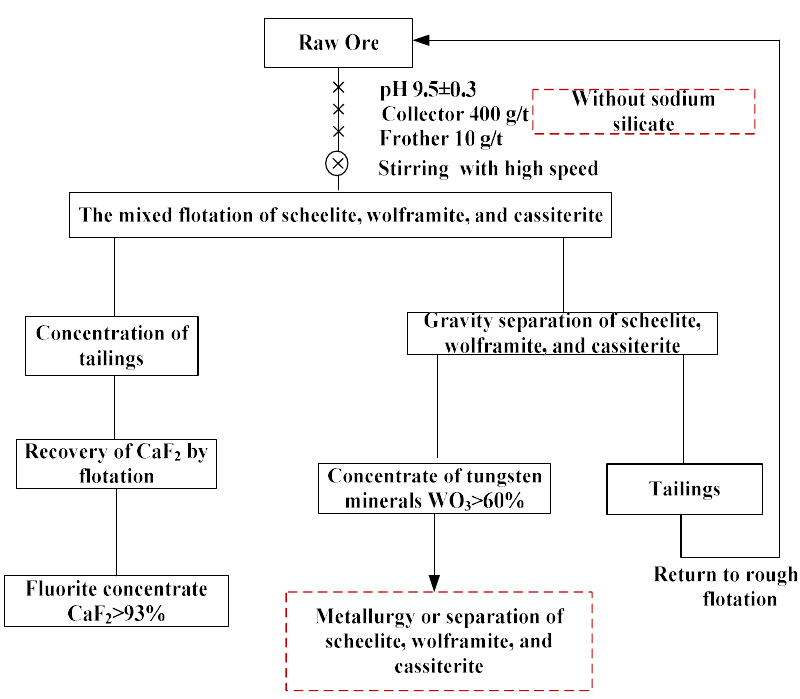
Figure 8. New flotation flowsheet of tungsten minerals in Shizhuyuan dressing plant.